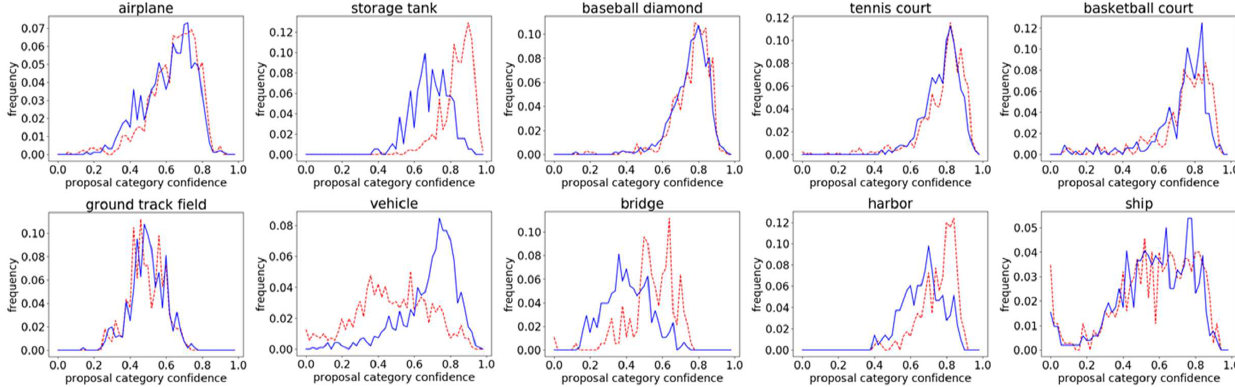
Figure 7. Frequency confidence curves of the proposed method (blue) and ground truth (red) for each class on the NWPU VHR-10 data